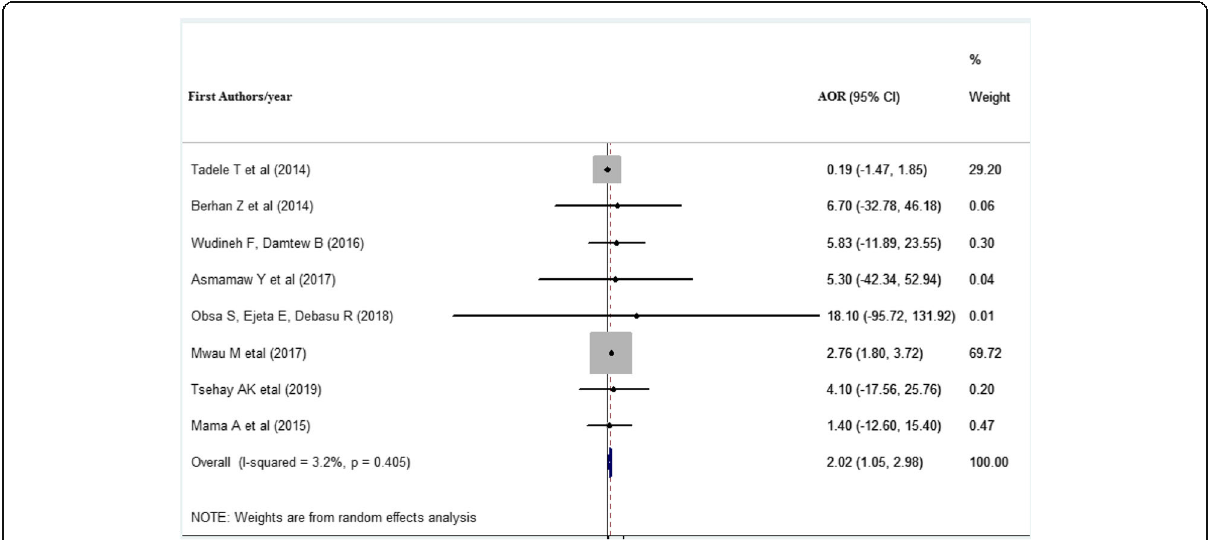
Fig. 5 Forest plot displaying the association of infants who were not received ART prophylaxis with vertical HIV infections among exposed infants in East Africa. The midpoint and the length of each segment indicated an AOR and a 95% CI, the arrow showed the widest CI, and the diamond shape showed the combined AOR of all studies for each